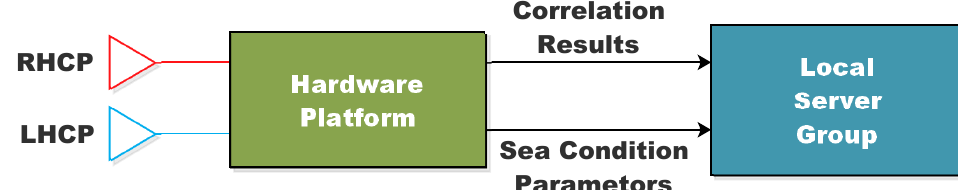
Figure 1. Information flow and the two layers of the prototype